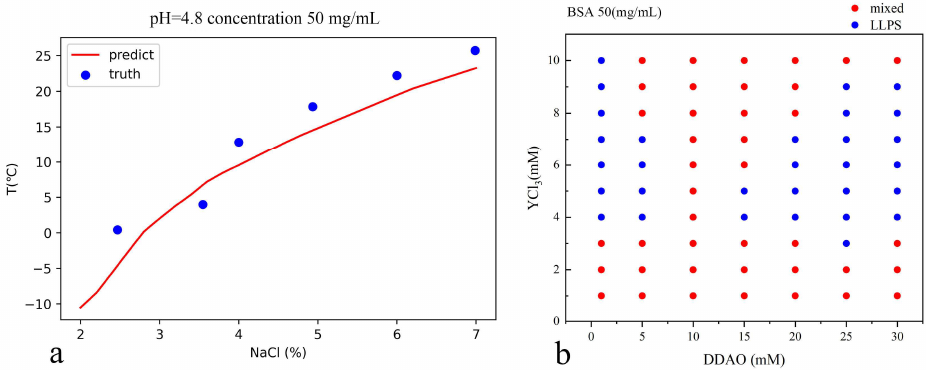
Figure 5. ( a ) The cloud point temperature map of the whole space when pH = 4.5 is established by using the neural network. ( b ) The phase diagram is made by using the neural network when the pH is 4.5 and the temperature is 20 °C. The neural network can be used to draw the phase diagram under given conditions in a certain range.